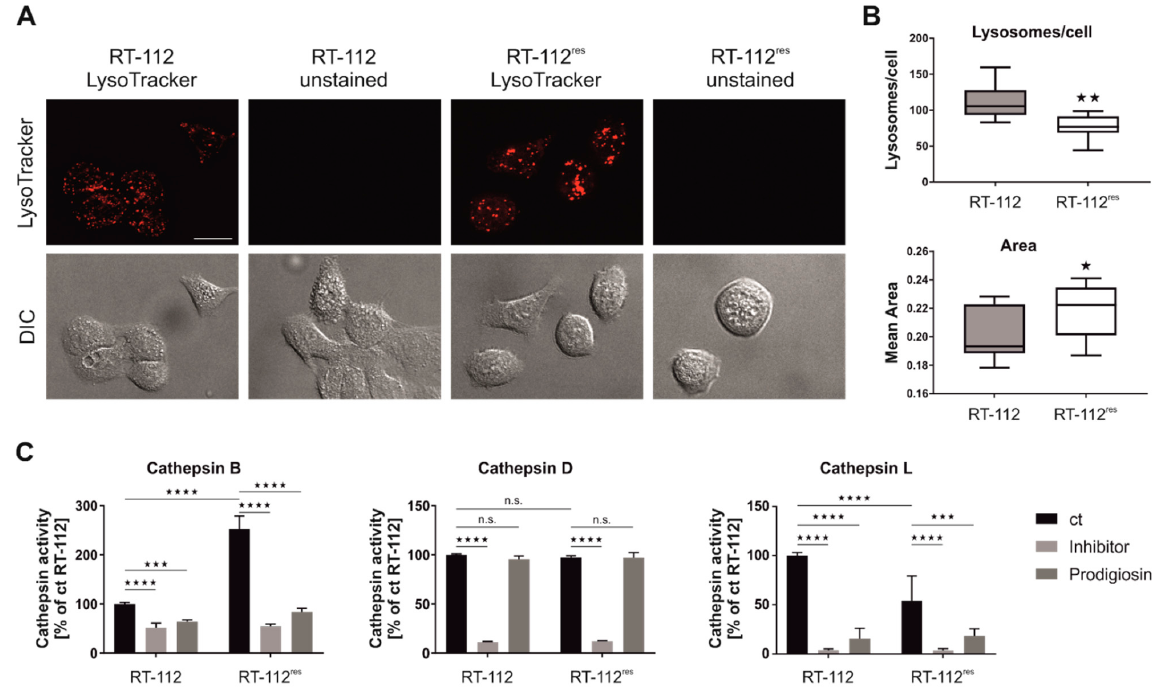
Figure 7. Prodigiosin treatment reduces cathepsin B and L activity in RT - 112 and RT - 112 res . ( A,B ) RT-112 and RT-112 res cells in chambered coverslips were treated with 100 nM LysoTracker TM Deep Red for 30 min. ( A ) Representative sections are depicted and ( B ) the number and area of lysosomes of 10 representative images from two biological replicates for each cell line were quantified using ImageJ 1.53c. P values were determined by Student´s t-test. Scale bar: 20 µm. ( C ) RT - 112 and RT - 112 res cells were treated with 100 nM prodigiosin. After 24 h, the cells were lysed and cathepsin assays were performed according to the manufacturer’s instructions. For cathepsin B and L assays, 20 µ M Z-Phe-Phe-FMK and for cathepsin D assays, 0.1 µ M pepstatin A were used as inhibitor control. The fluorescence of duplicates for each treatment of three independent experiments was measured and the mean of the DMSO control of RT-112 was set as 100%. Bars represent the means + SD. P values were deter- mined by two-way ANOVA with Tukey´s multiple comparisons post hoc test. * p < 0.05; ** p < 0.01; *** p < 0.001; **** p < 0.0001.